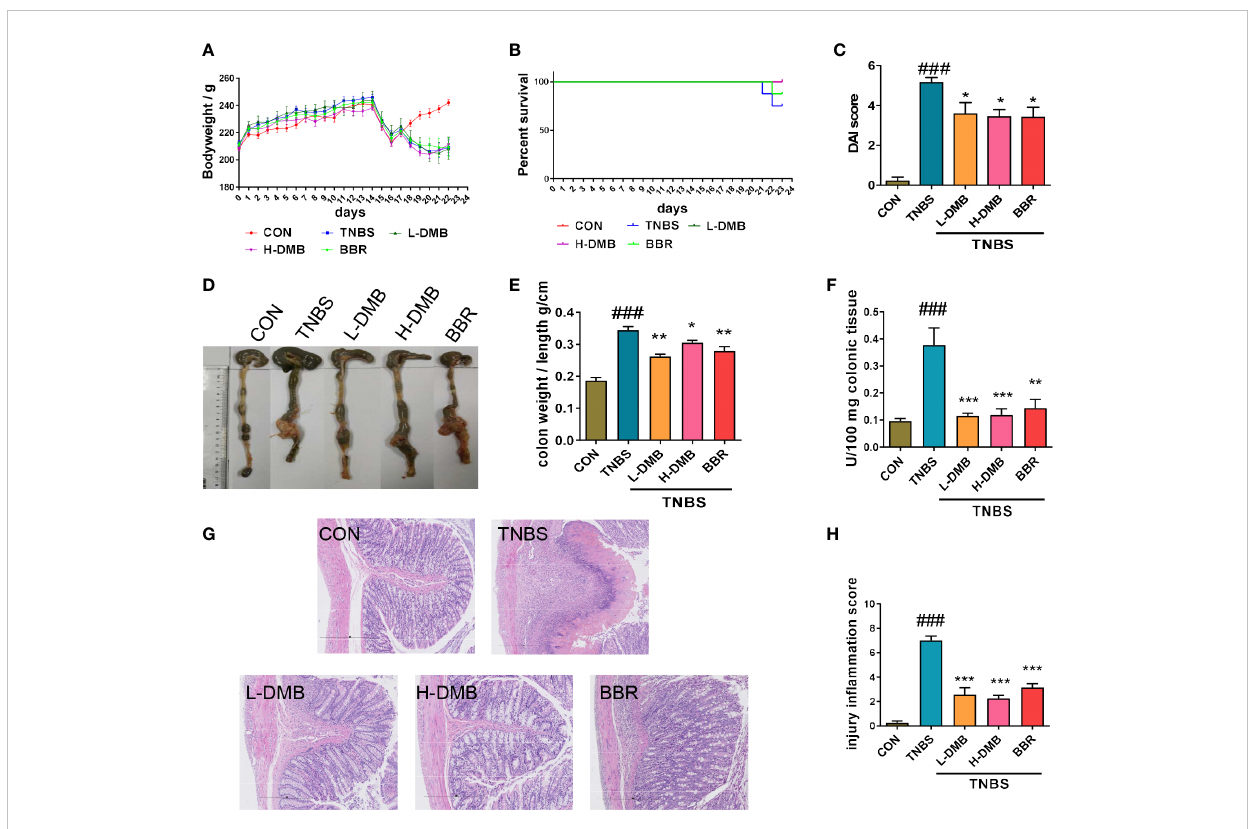
FIGURE 2 DMB relieved intestinal barrier injury by inhibiting TLR4 signaling in the experimental rat CD model. (A) The body weight of rats in the CD model. (B) The percentage survival of rats. (C) DAI scores of rats in different groups. (D) Macroscope of colonic tissues of rats in different groups. (E) Colon mass score marked with the ratio of colon weight and colon length. (F) The MPO activity in colonic tissues. (G) H&E staining of colonic tissues (100×) in CD rats. (H) Injury in fl ammation score of colonic tissue. Statistical analysis was performed using one-way ANOVA. n = 8. ### p < 0.005 (#: the TNBS group versus the CON group) and * p < 0.05, ** p < 0.01, *** p < 0.005 (*: the DMB or BBR group versus the TNBS